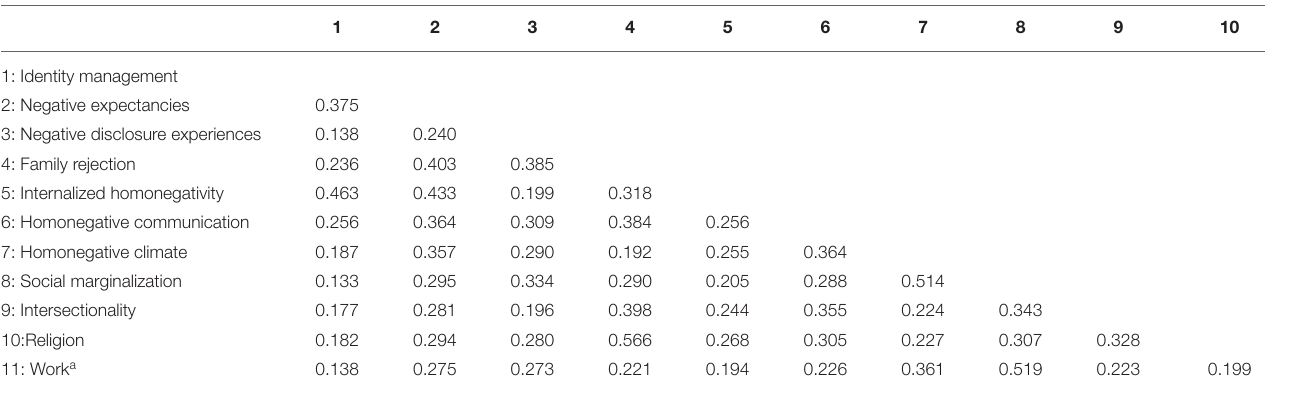
TABLE 3 | Correlations among SMASI